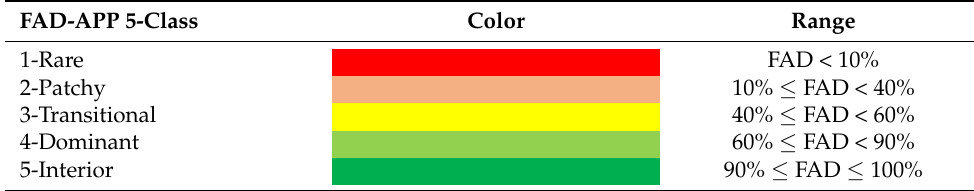
Table 3. Fragmentation classes (FAD-APP 5-class).